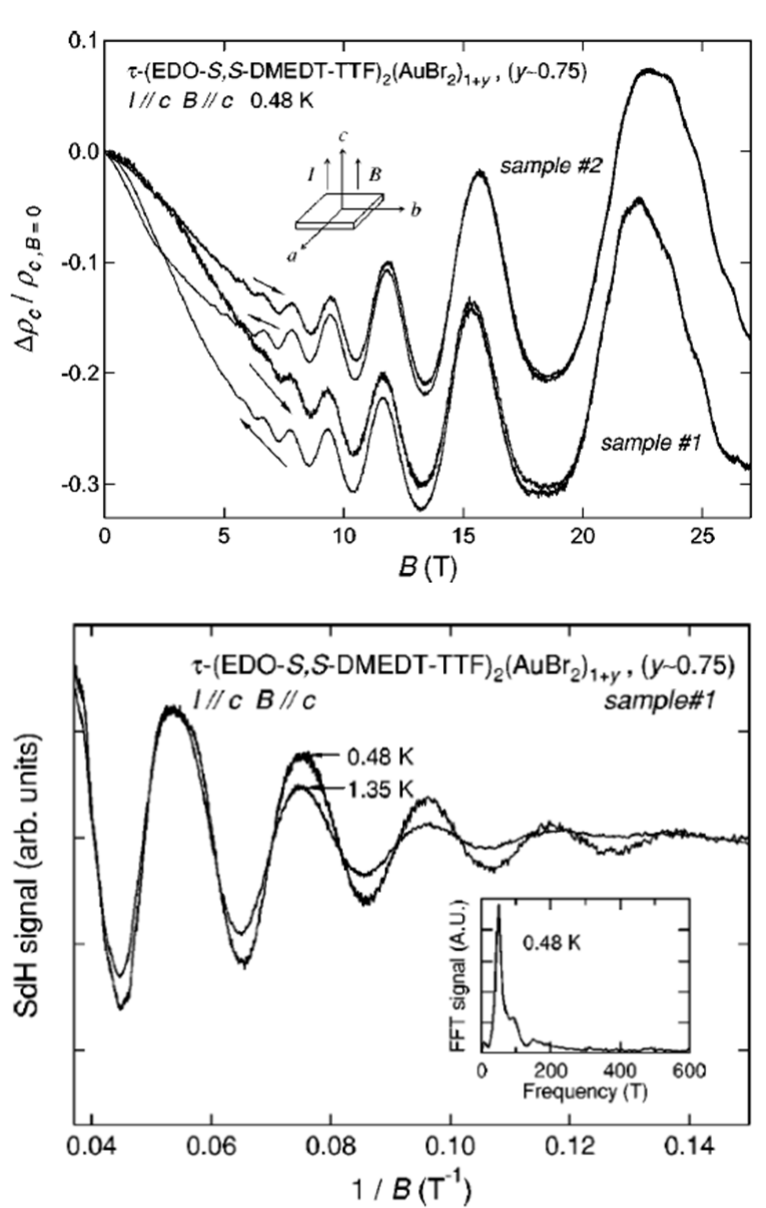
Figure 10. Giant Shubnikov-de Haas oscillation in τ -(EDO- S , S -MEEDT-TTF) (top), and it 1/ B -plot (bottom) [89]. Reproduced with permission from Physical Review B